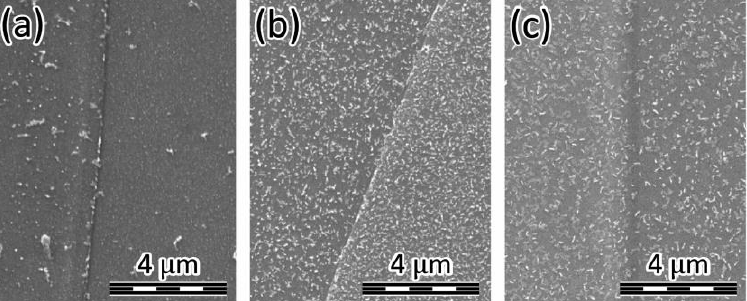
Figure 6. SEM micrographs showing the nanometric carbides formed in grain boundary zones after 1100 °C isothermal treatments with water quenching at: ( a ) 1 h, ( b ) 4 h and ( c ) 16 h.